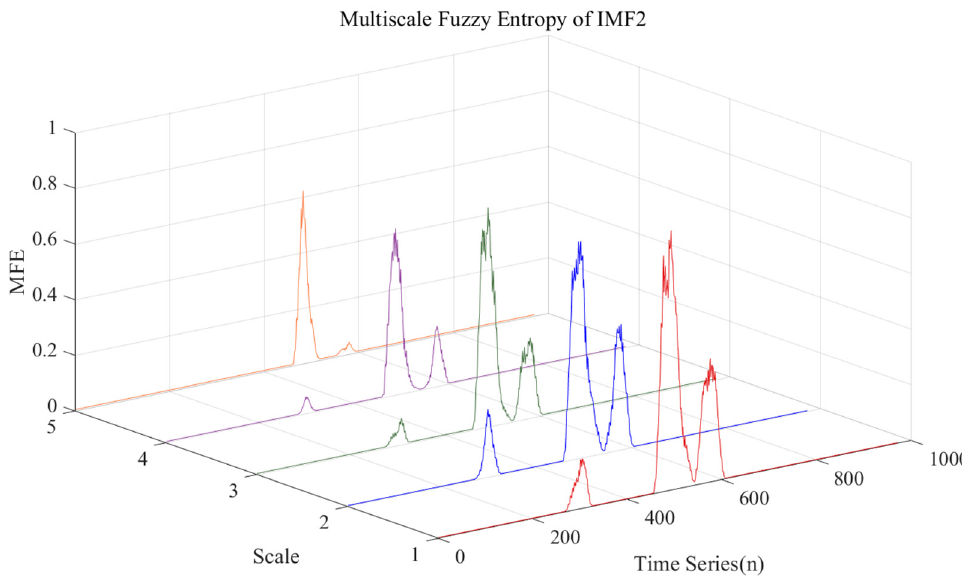
Figure 16. IMFE under different scales of IMF1.